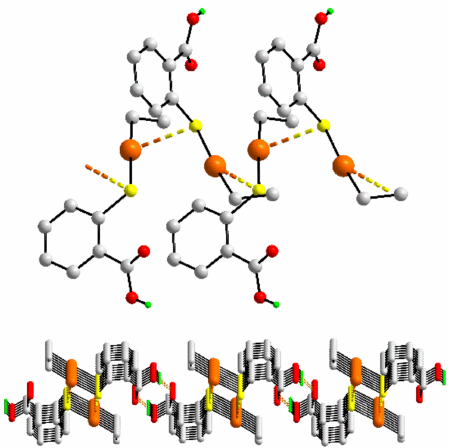
Figure 18. Supramolecular association in the crystal of 48 : upper view—a one-dimensional aggregate with a helical topology and featuring Hg ··· S interactions; lower view—supramolecular layer formed through carboxylic acid-O–H ··· O(carbonyl) hydrogen bonding. Here, the chains of the upper view are connected into a two-dimensional assembly via hydrogen bonding (non-participating hydrogen atoms are